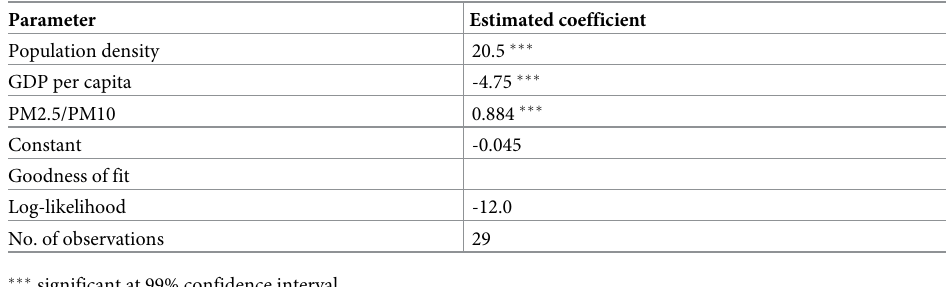
Table 1. Estimated parameters from the